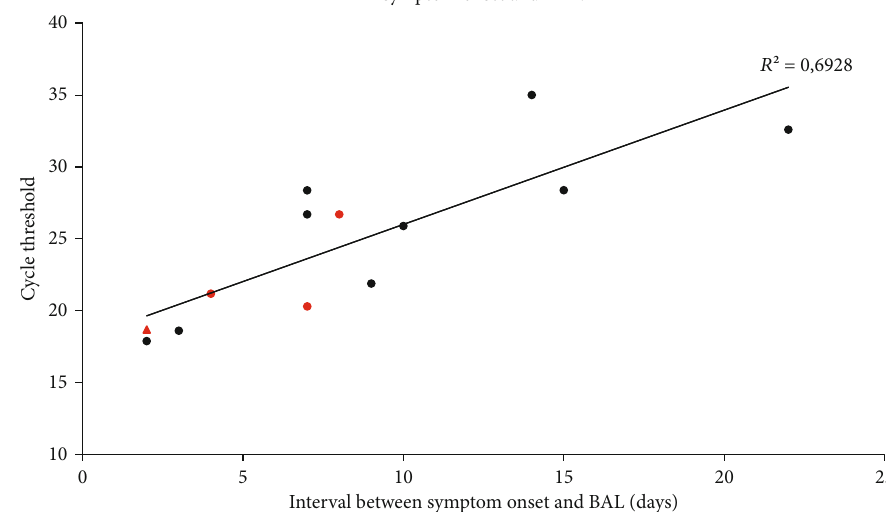
Figure 2: Cycle threshold of the RT-PCR for SARS-CoV-2 in BAL fl uid by the interval of time from onset of symptoms at time of BAL procedure in 13 SARS-CoV-2-positive patients. The Pearson correlation coe ffi cient was 0.8, p = 0 : 0004 . Dots and triangle represent the patients alive and dead, respectively, 4 weeks after the BAL. Red markers represent the patients admitted to the ICU. Abbreviations: BAL — bronchoalveolar lavage; RT-PCR — reverse transcriptase polymerase chain